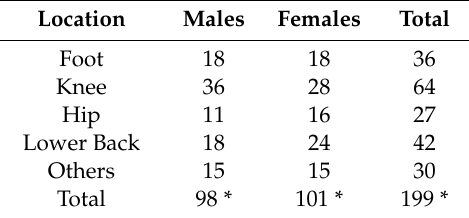
Table 2. Pain, stratified by sex and location reported by the race